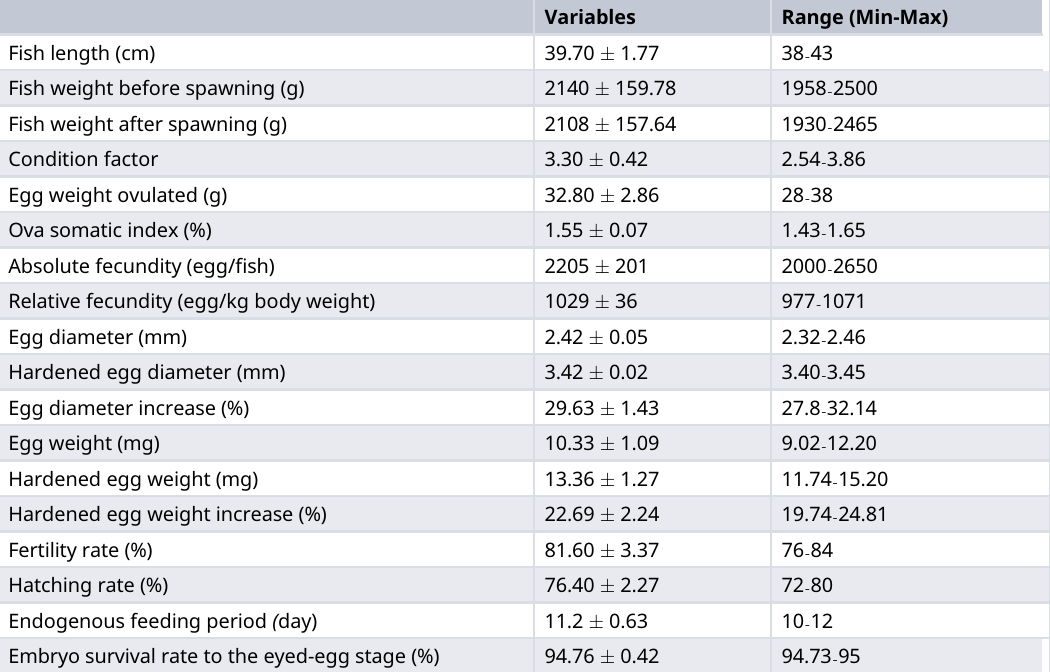
Table 1. Reproduction characterization in sago strain of giant gourami females broodfish (Mean (cid:3)